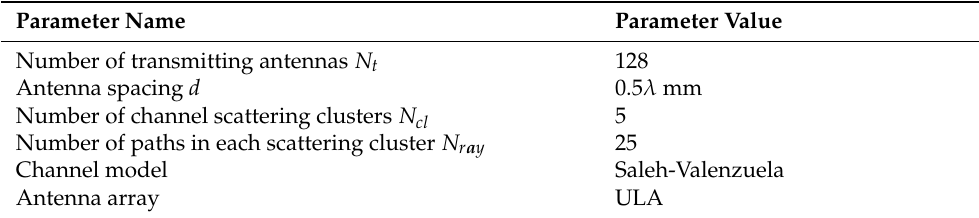
Table 1. Simulation